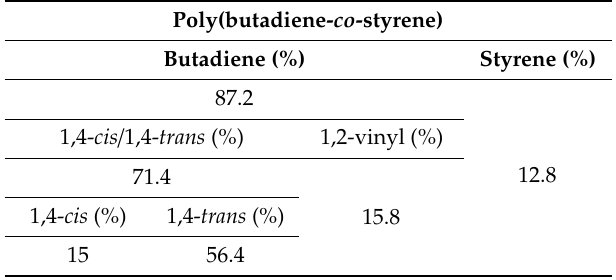
Table 4. Results of SBR composition and microstructure of HD-SBR#01 obtained from 1 H and 13 C NMR.